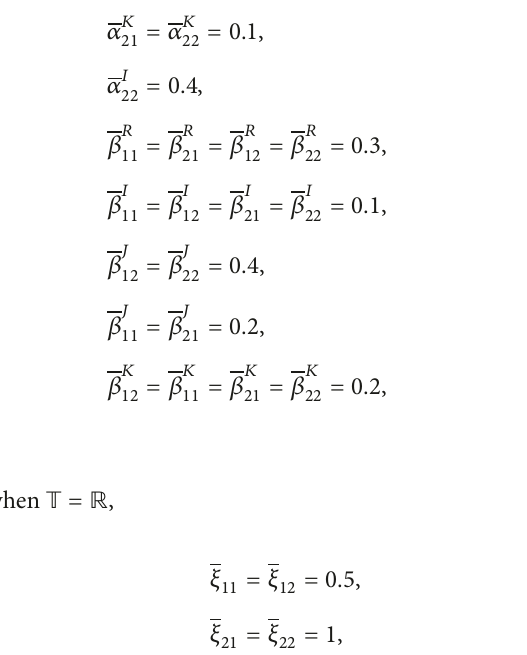
Figure 1: Responses of the four parts of 𝑥 with continuous time